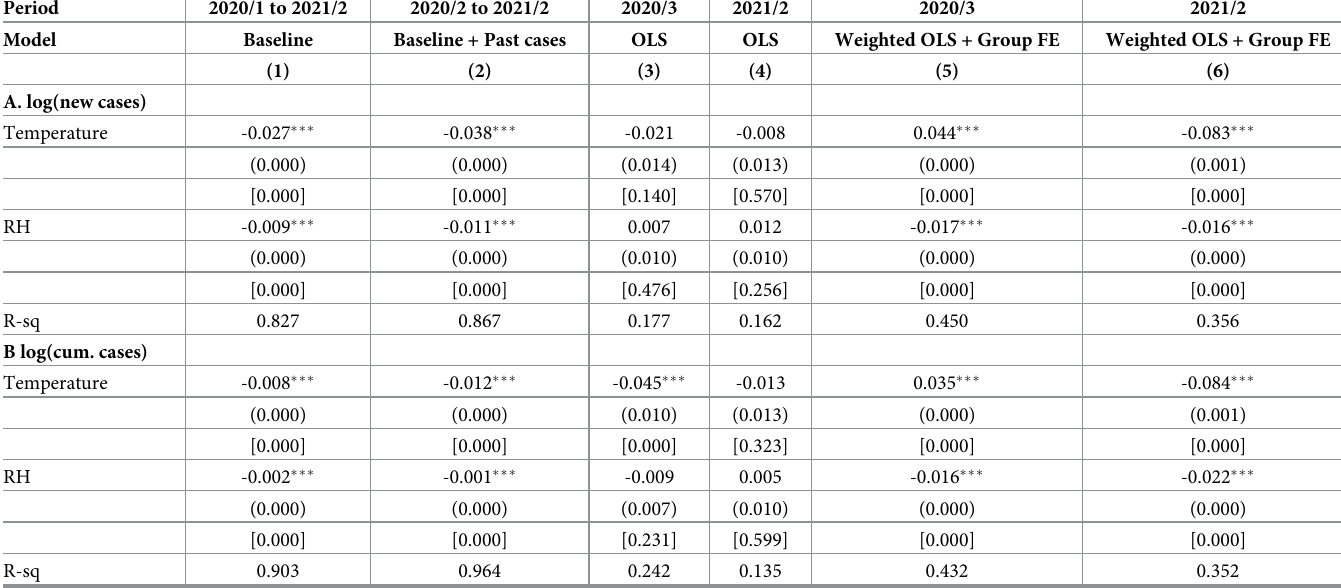
Table 1. Effect of temperature and relative humidity on the logarithm of monthly new COVID-19 cases and cumulative cases across 174 countries from Jan. 2020 to Feb. 2021. Period